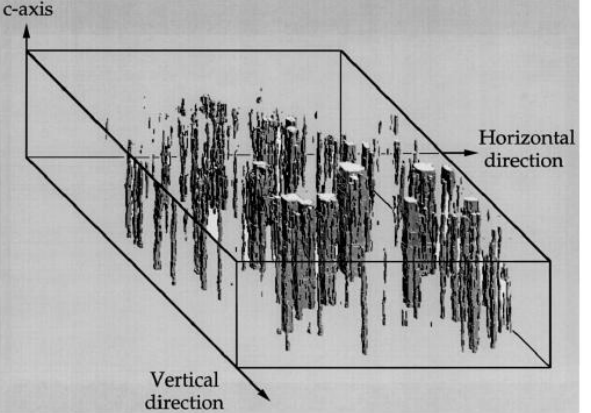
Figure 9. A 3-dimensional map of 180° domains in barium titanate crystals (Grubsky et al ., 1996